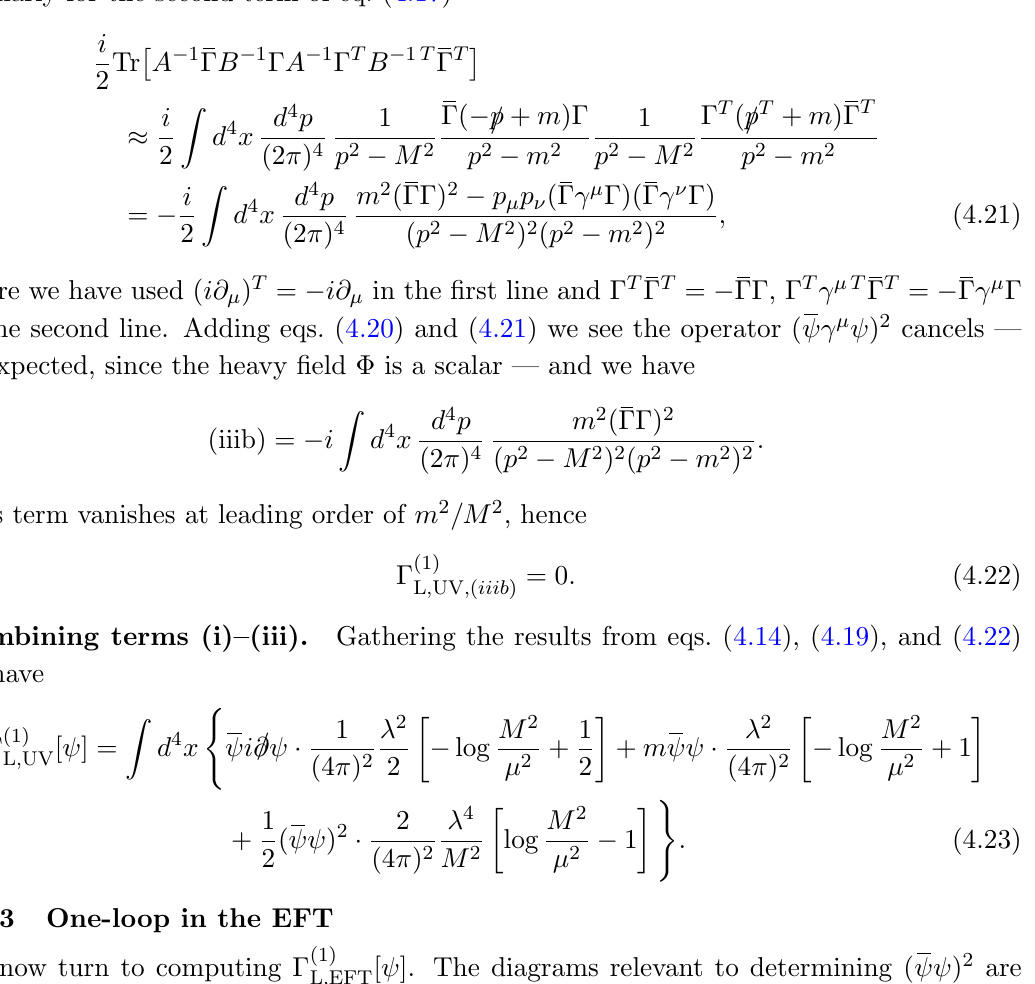
Figure 3 . How the diagrams of (cid:12)gure 1 appear in the functional evaluation of (cid:0) (1) to follow the (cid:13)ow of fermion number, the four-fermion vertices intentionally do not touch.